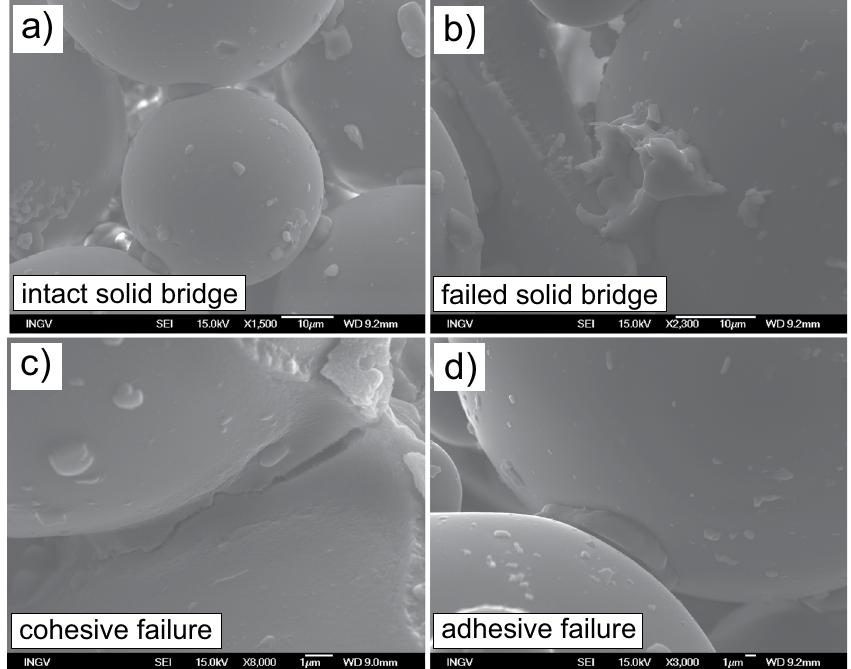
Figure 4. ( a ) An intact solid NaCl bridge connecting two glass beads. ( b ) A failed solid NaCl bridge with the once connected glass bead missing. ( c ) Cohesive failure within a solid NaCl bridge. ( d ) Adhesive failure between a solid NaCl bridge and a glass